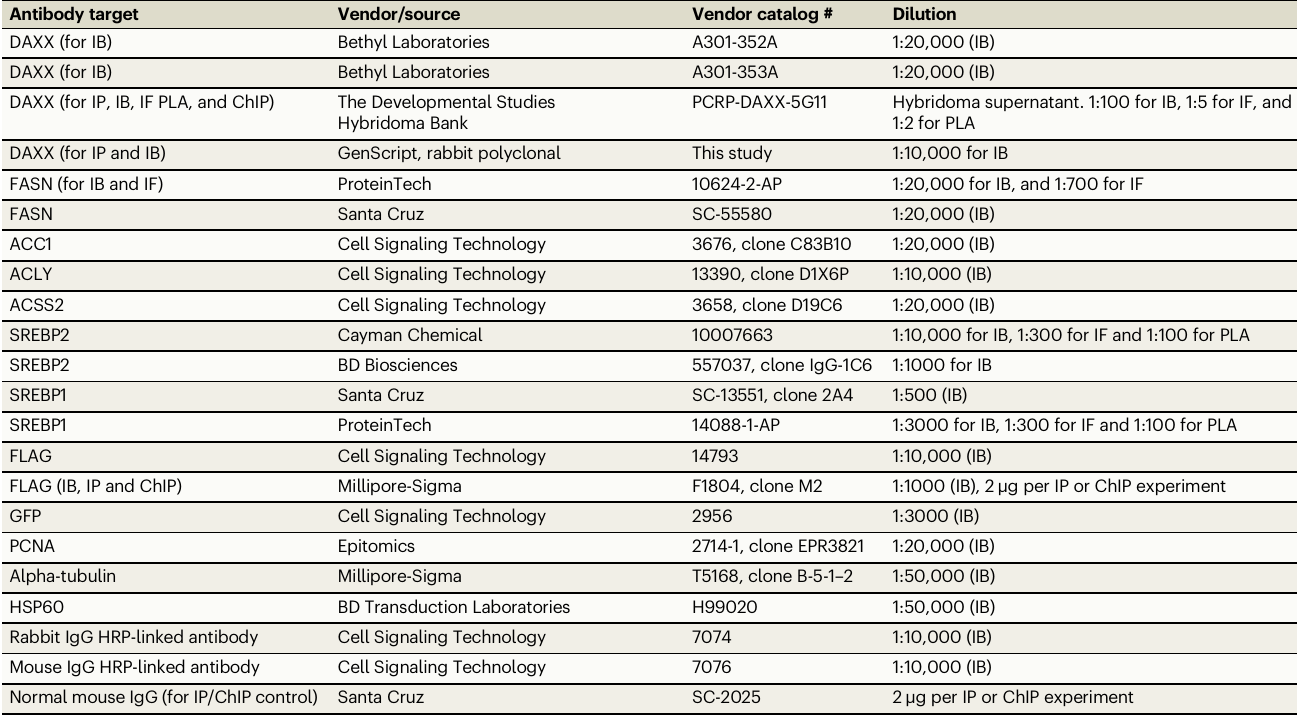
Table 2 | Antibodies used in this